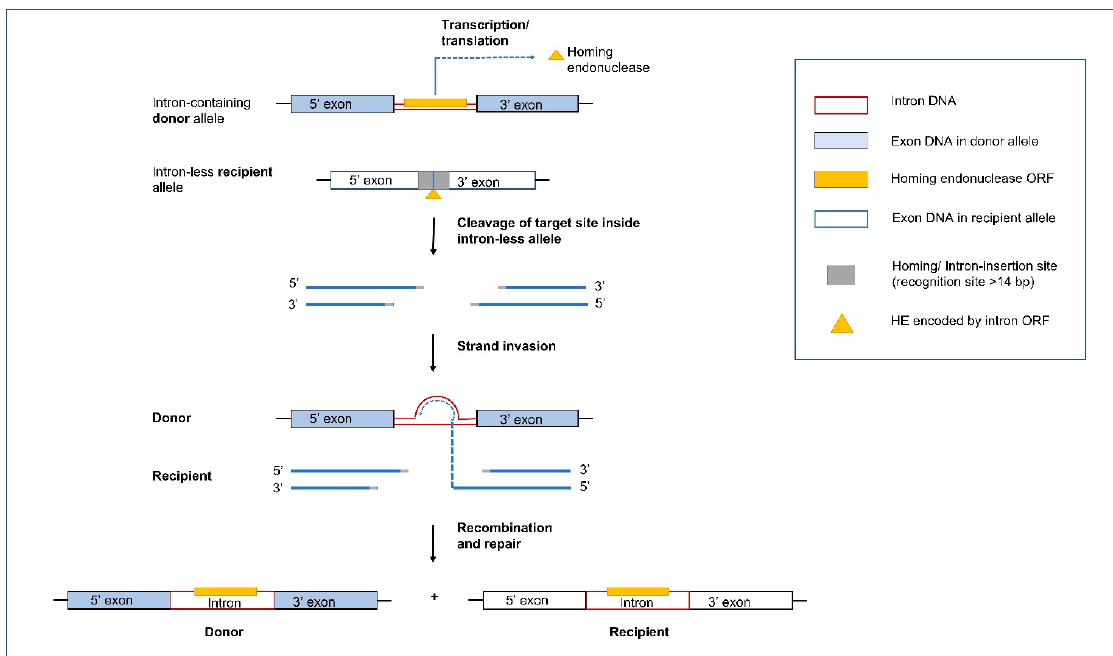
Figure 5. Mobility pathway of the Group I introns through homing. Intron homing is mediated by homing endonucleases (HE, yellow triangle) encoded by the HE-ORF (yellow box) in the intron-containing donor allele. Homing endonuclease target sites (grey box) are typically centered on or near the intron-insertion site in the intron-less recipient allele and include DNA sequences both upstream and downstream of the intron insertion site (usually > 14 bp). The HE introduces a double stranded break (DSB) or a single stranded nick in the intron-less allele. This DSB or nick are repaired by recombination based DSB repair pathway that uses the intron containing allele as a donor template. The end result is the non-reciprocal transfer of the mobile intron element into the intron-less